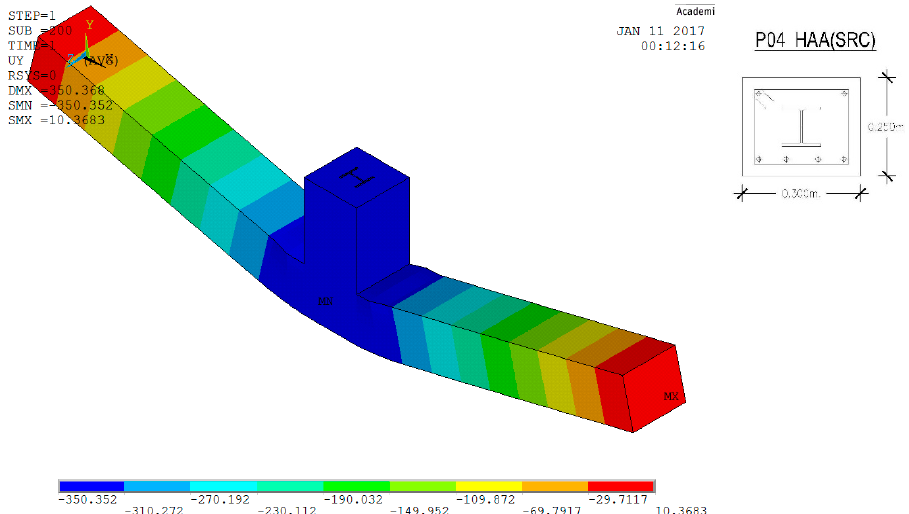
Figure 18. Deflection of the beam (in mm) for a 350 mm deflection.